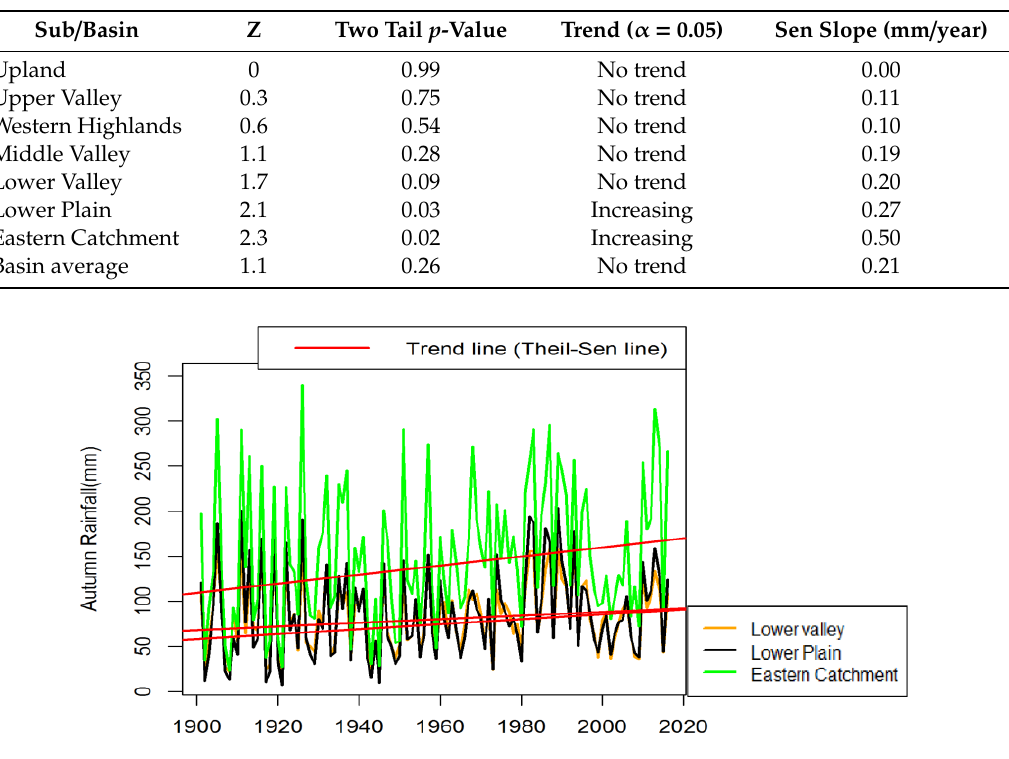
Figure 12. Autumn rainfall time series showing significant increasing trends for the period 1900 – 2016.